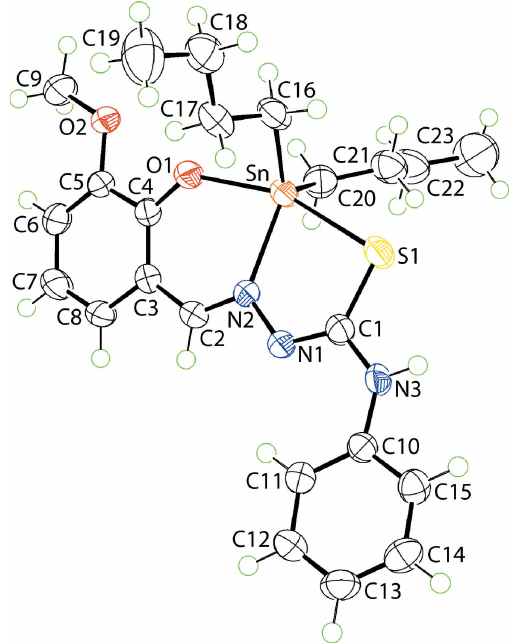
Figure 1 The molecular structure of (I) showing the atom-labelling scheme and displacement ellipsoids at the 70% probability level.